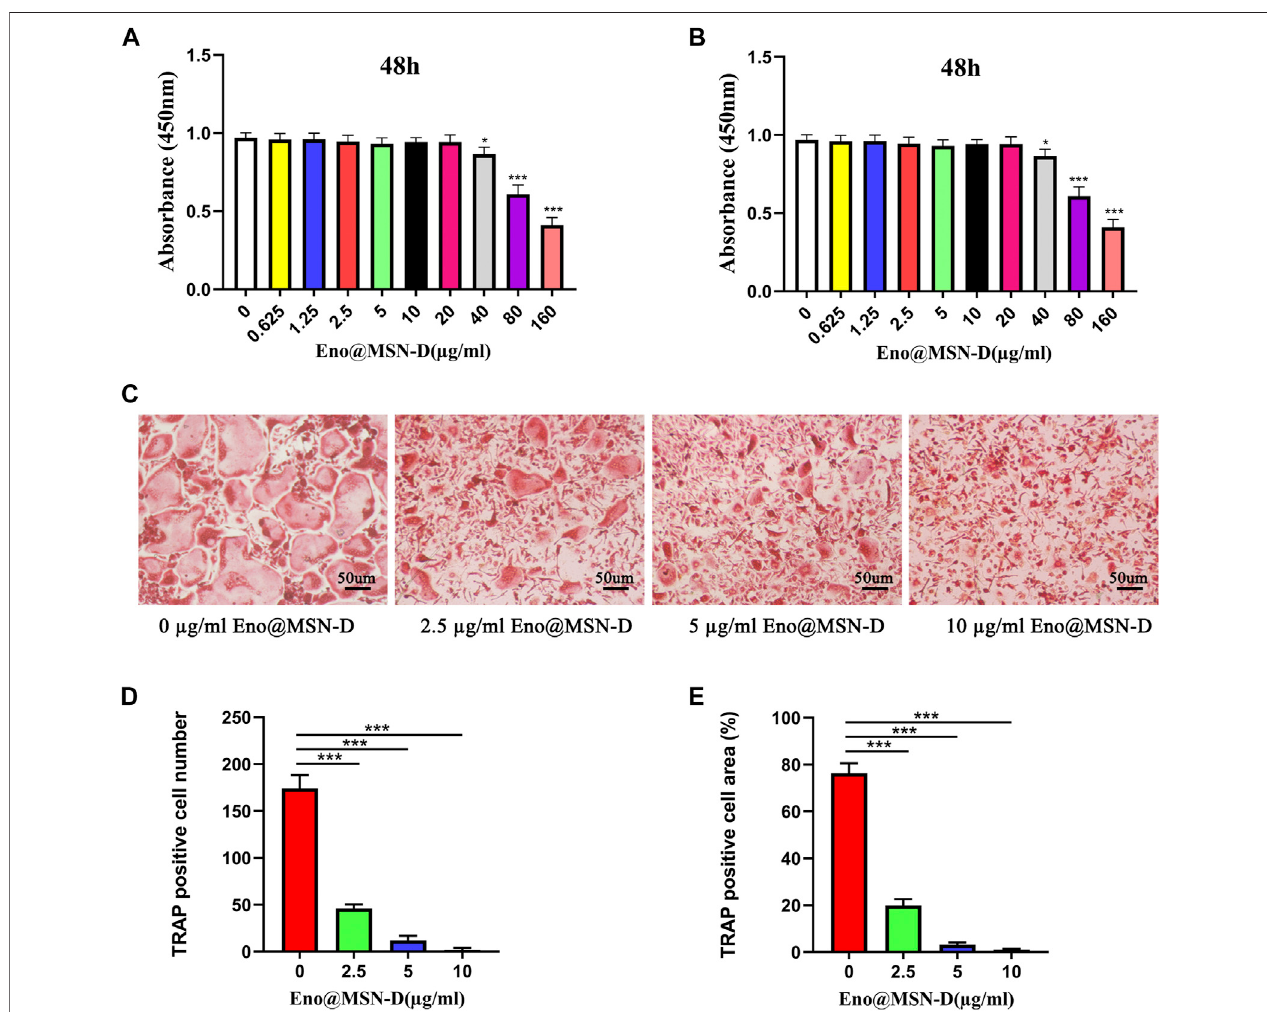
FIGURE 5 | (A,B) BMMs were plated in 96-well plates and stimulated with M-CSF (30 ng/ml) and different concentrations of Eno@MSN-D (0 – 160 μ g/ml) for 48 or 96 h. Cell viability was measured using the CCK-8 assay. (C) Bone marrow macrophages (BMMs) were treated with various concentrations of Eno@MSN-D (0, 2.5, 5, and 10 μ g/ml) followed by M-CSF and RANKL stimulation for 5 days. The cells were then fi xed with 4% paraformaldehyde and subjected to tartrate-resistant acid phosphatase (TRAP) staining. (D,E) The number and spread area of TRAP-positive multinuclear cells were